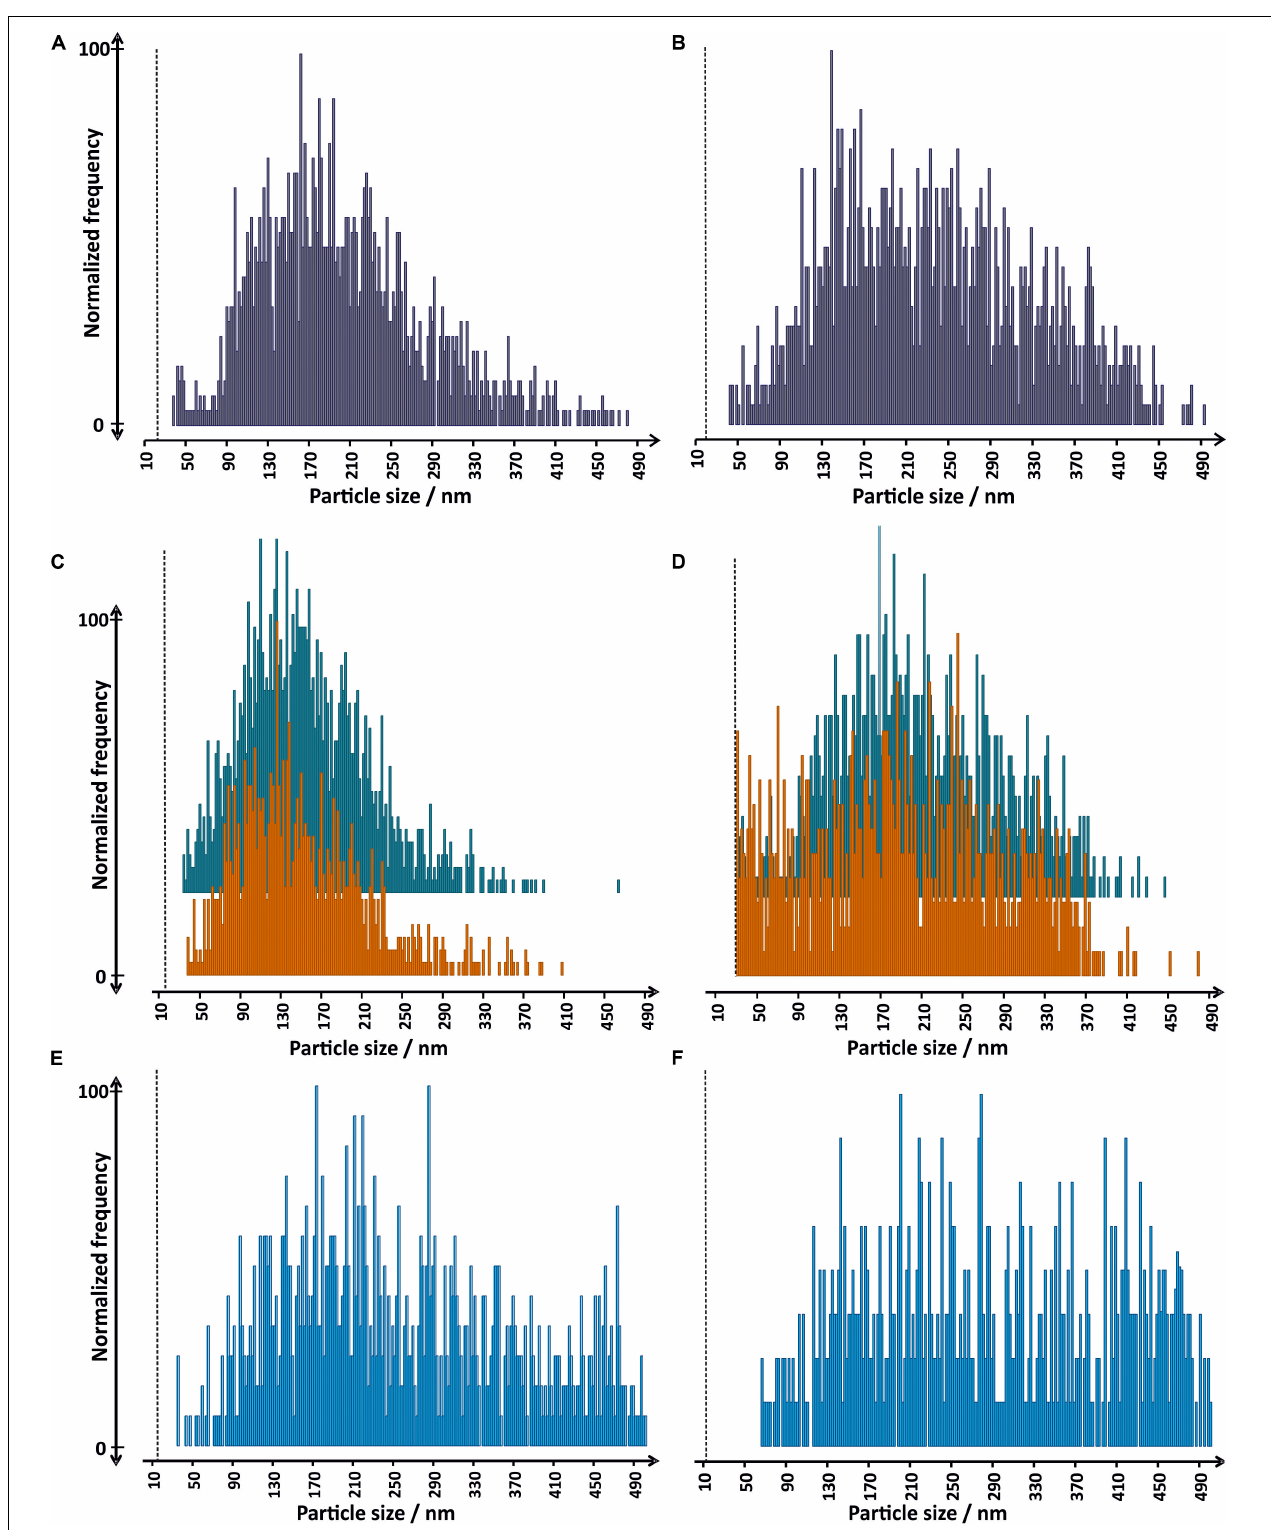
FIGURE 2 | Size distributions obtained by SP-ICP-MS for commercial TiO 2 NP suspensions in ultrapure water: (A) A and (B) B, used during plant cultivation; TiO 2 NP stock suspension (C) A, and (D) B, freshly prepared (blue) and after enzymatic digestion procedure (orange); and commercial suspensions (E) A and (F) B, after 7 days in contact with growth medium. Vertical lines represent the size limit of detection for each sample.